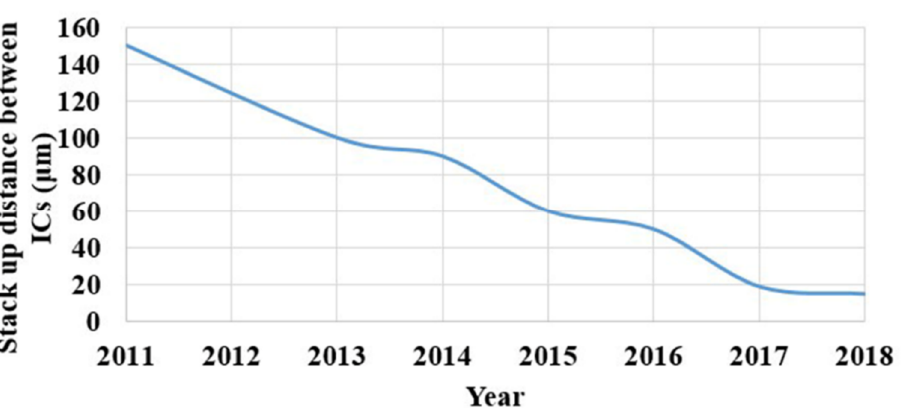
Figure 1. Three-dimensional stack-dies integrated circuits (3D-ICs) trend for vertical distance between ICs [16–23].